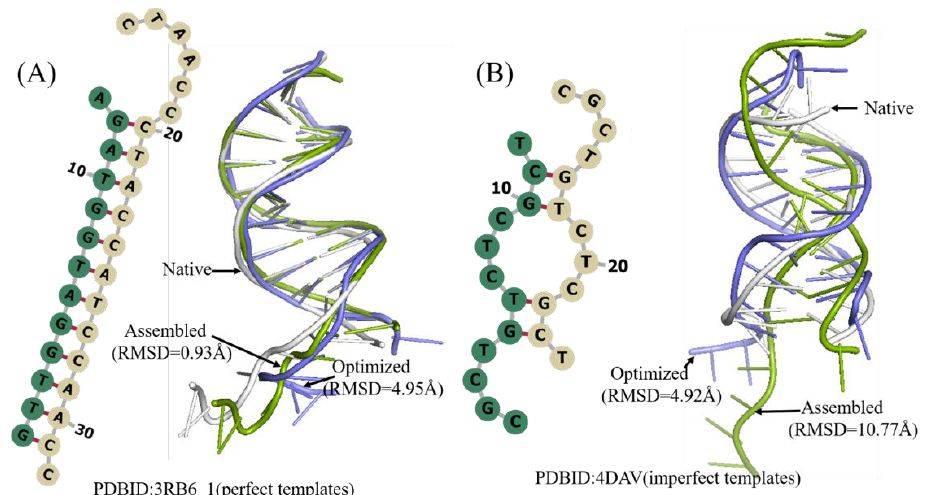
Figure 5. Two examples of the predicted 3D structures of double-chain DNA by 3dDNA. ( A ) The 2D and 3D structures of DNA 3RB6_1 with perfect template, the RMSD of assembled (green) and optimized (blue) structures with a native one (grey) are 0.93 Å and 4.95 Å, respectively. ( B ) The 2D and 3D structures of DNA 4DAV with imperfect template; the RMSD of assembled (green) and optimized (blue) structures with a native one (grey) are 10.77 Å and 4.92 Å, respectively.